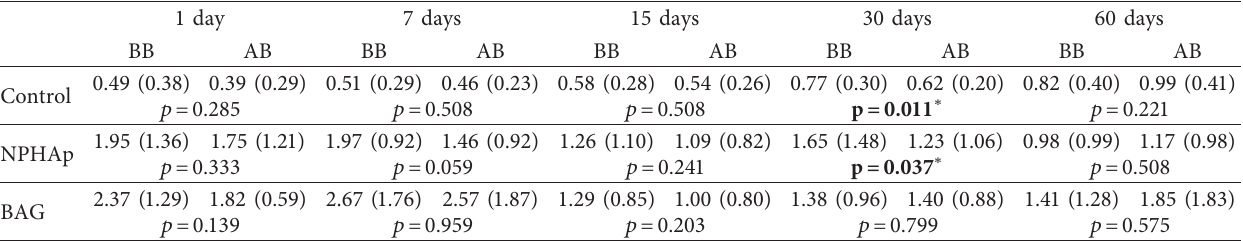
Table 2: Surface roughness (Ra) before and after the brushing test for each time interval (days), for each experimental group-mean (standard deviation).